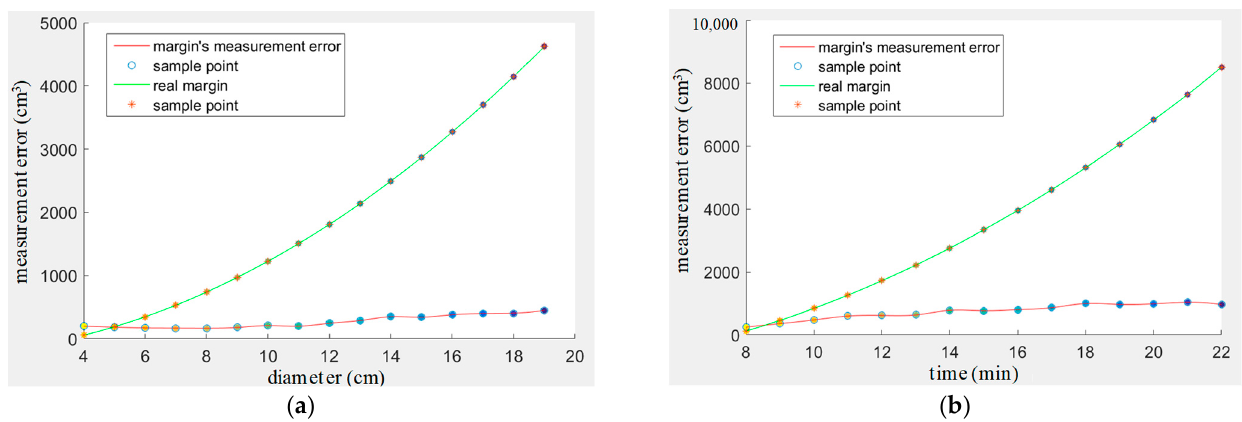
Figure 17. Yarn roll’s margin measurement error. ( a ) Conic yarn roll. ( b ) Cylindrical yarn roll.